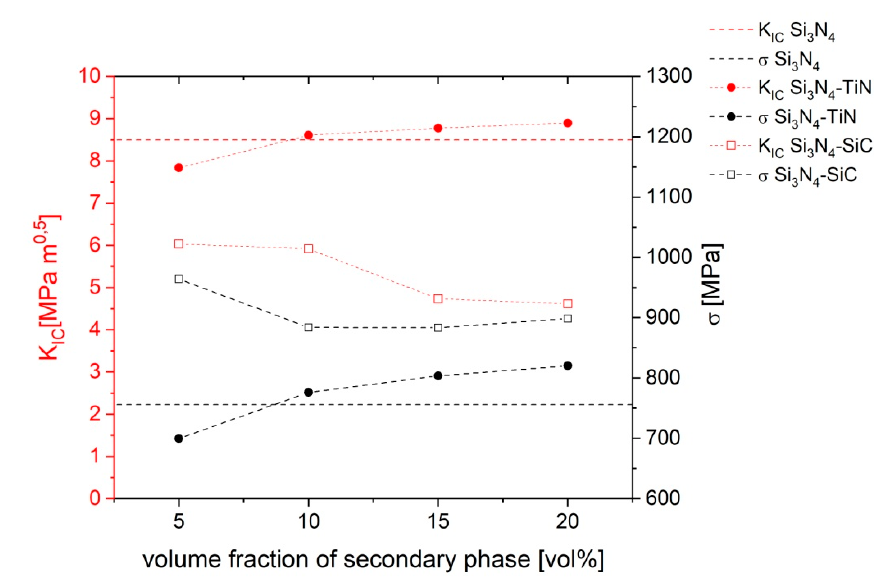
Figure 4. Fracture and strength of materials.